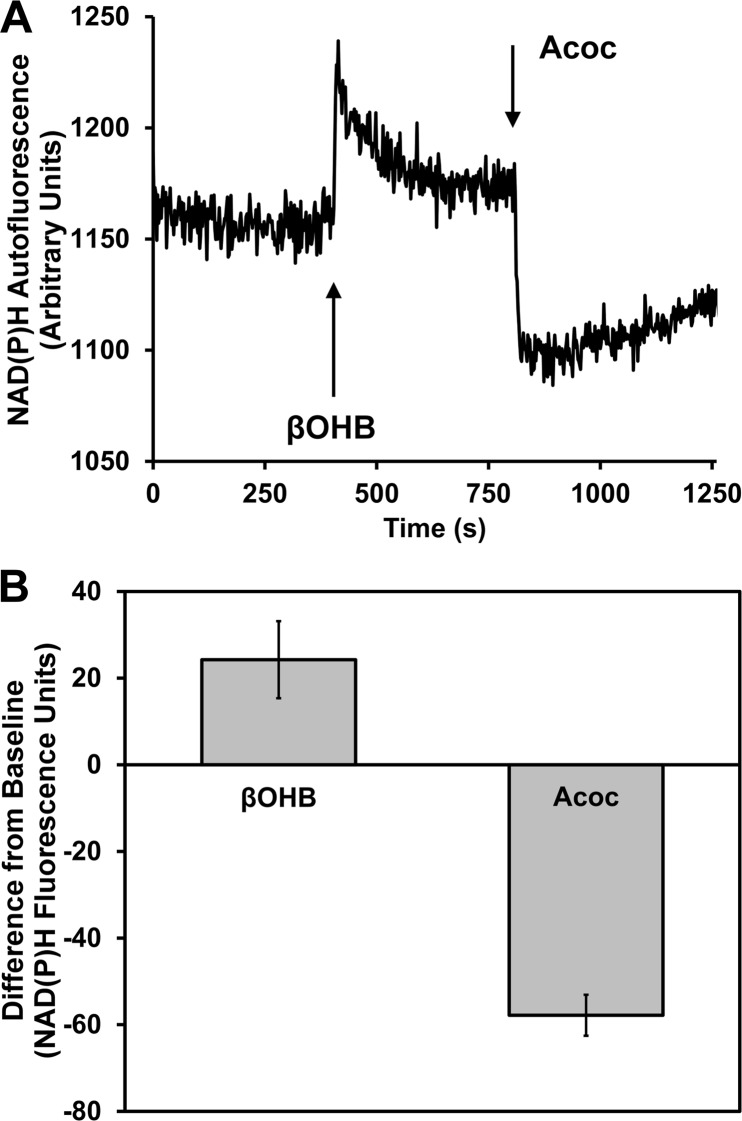
External addition of reduced or oxidized ketone bodies affect the internal redox state.NAD(P)H fluorescence was measured within hepatocytes in suspension using a fluorometer. A) Changes in fluorescence correspond to the addition of external, sequential addition of 40 mM of a 50/50 mixture of l- + d-βOHB or 20 mM Acoc at the points indicated. This trace is one representative trace of three independent experiments. B) Quantification of the change in arbitrary fluorescence units upon addition of βOHB or Acoc to baseline (without previous addition of either ketone body; n = 5 independent experiments, p = 0.003, t-test).